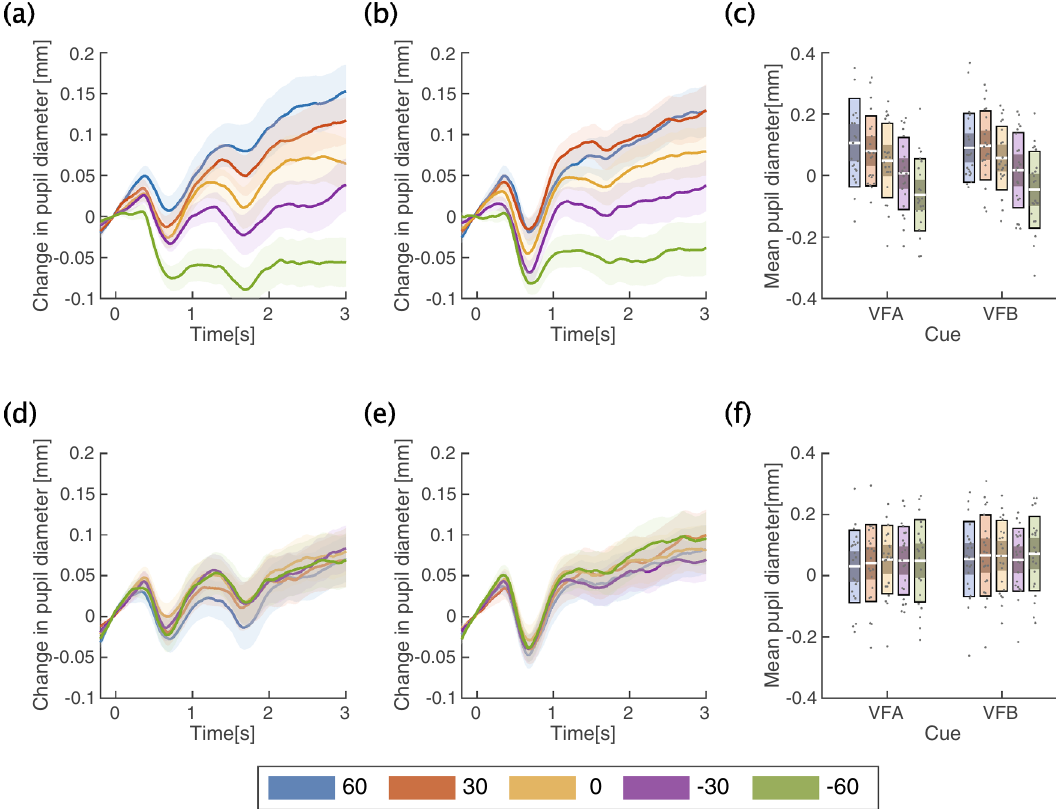
Figure 4. Pupillary results in Experiment 1. (a) Time course of average pupil diameter when viewed from above (VFA) was cued in the vertical condition across all participants. (b) Time course of average pupil diameter when viewed from below (VFB) was cued in the vertical condition across all participants. (c) Average pupil diameter from 1 to 3 s in the vertical condition. (d) Time course of average pupil diameter when VFA was cued in the horizontal condition across all participants. (e) Time course of average pupil diameter when VFB was cued in the horizontal condition across all participants. (f) Average pupil diameter from one to three seconds in the horizontal condition. In (a,b,d,e) , the line shows the average pupil diameter, and the shaded color shows the standard error of the mean (SEM). In these figures, the cues were presented in the range from 0 to 1 s, and the ambiguous Necker cube was presented from one to three seconds (the range of baseline was −200 ms to 0 s, which was presented as the fixation point). In ( c,f ), the white line indicates the mean of participants, the light color indicates 1.96 SEM (95% confidence interval), the dark color indicates one standard deviation, and each gray dot indicates the mean of each participant. Each color represents the angle at which the stimulus was